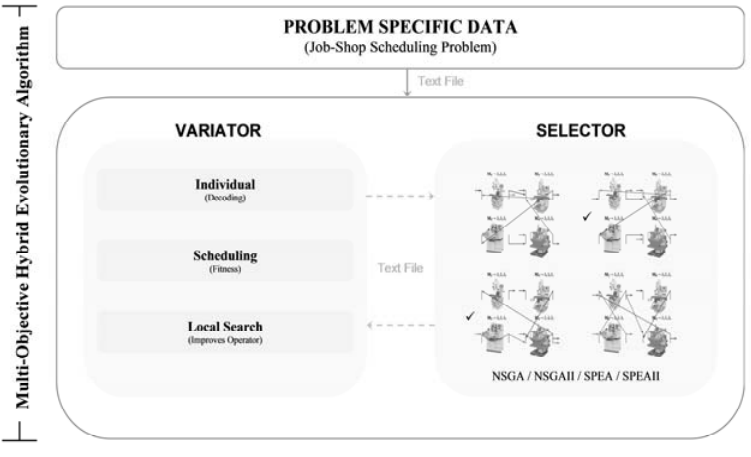
Fig. 4. The architecture of